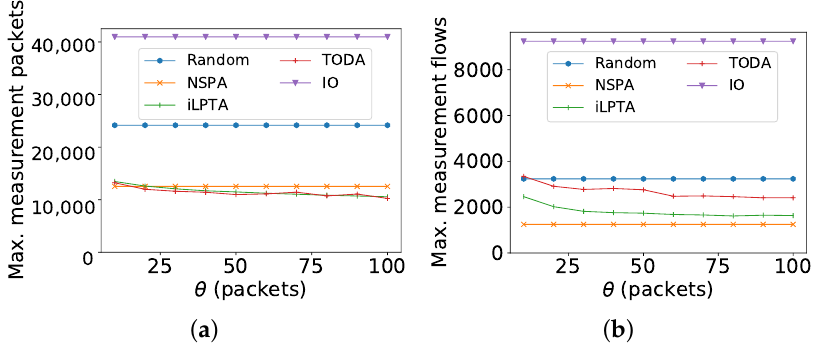
Figure 8. Impact of the fraction of large flows with different θ . ( a ) Maximum measurement packets; ( b ) Maximum measurement flows.